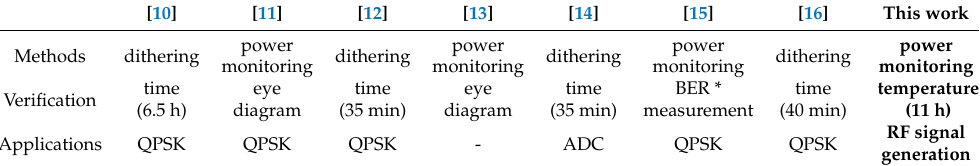
Table 1. Comparison with the previous research results of automatic bias control